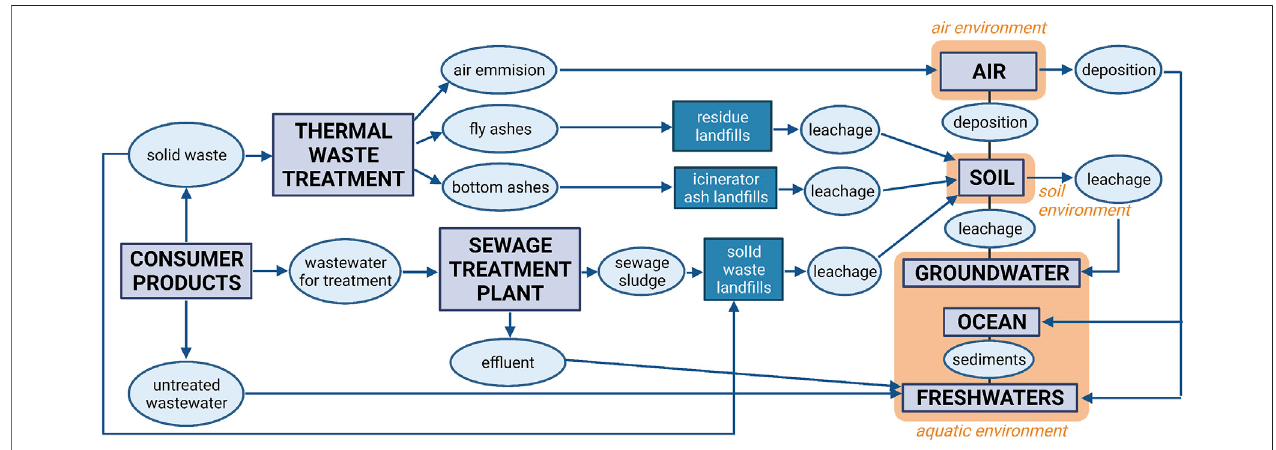
FIGURE 7 | Schematic of potential transfer pathways of the RGO/Al 2 O 3 nanocomposite in the natural environment as a result of their release from consumer products. Arrows correspond to the directions of transfer between the environmental biota (Reproduced with permission from (Jastrze ˛ bska and Olszyna, 2015) with minor